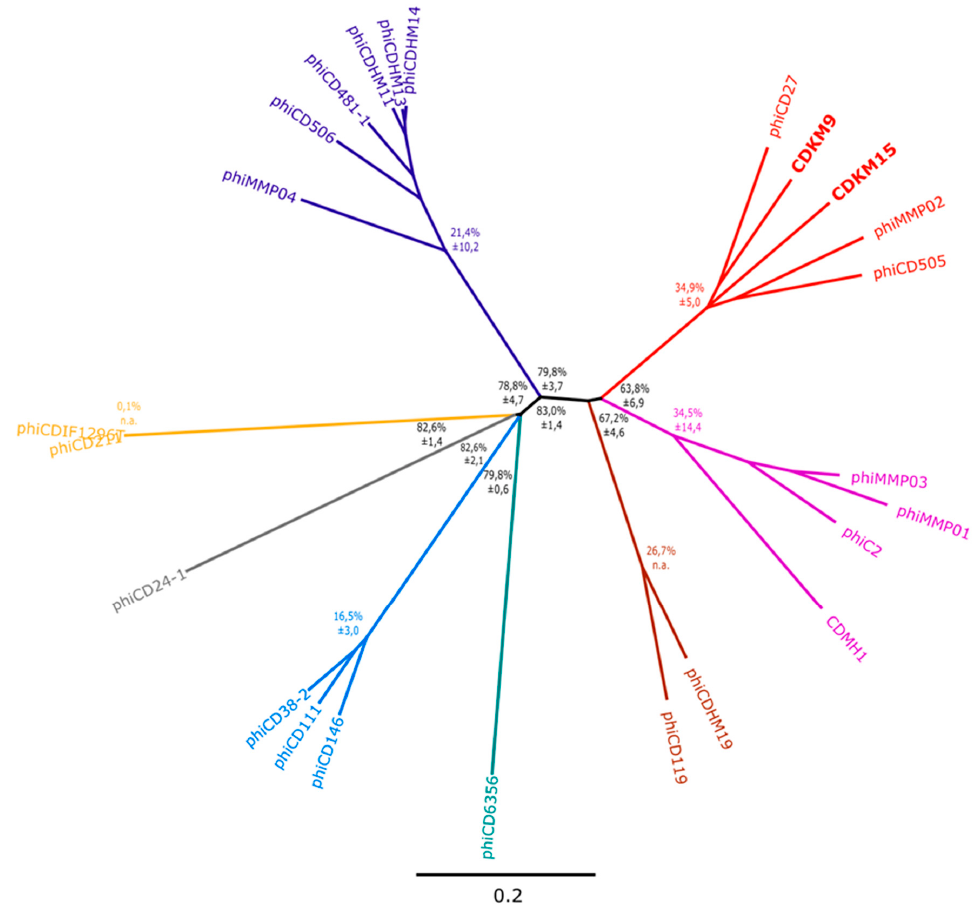
Figure 5. Phylogenetic tree based on whole genome comparison of C. difficile phage genomes. The similarity values were calculated based on a translated pairwise comparison of the analysed sequences using Gegenees software. The phylogenetic tree was constructed with SplitsTree using the neighbor joining method. The scale bar represents a 20% difference in average tBLASTx score. Branch colours correspond to the colours in Figure 6. Black node markers represent mean percentage distance between the clades (calculated by averaging each distance between group 1 member and group 2 member) ± standard deviation. Coloured node markers represent the mean percentage distance within the clade (calculated by averaging distances between group members) ± standard deviation. Distance is defined as 100% similarity in translated whole genome comparison.